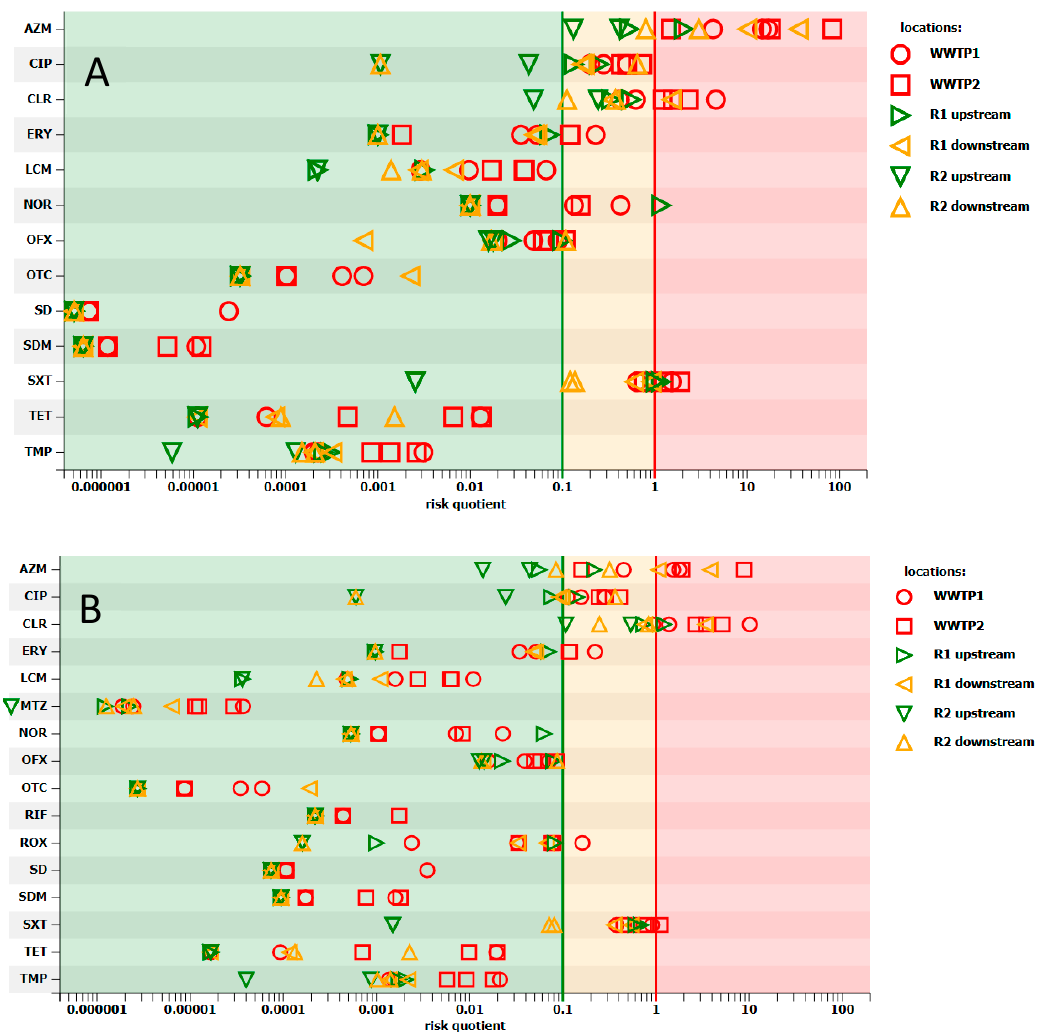
Figure 5. Estimation of risk quotients of chronic exposure of cyanobacteria ( A ) and eukaryotic organisms ( B ) to the antimicrobials occurring in effluents and receiving water. Calculations were based on the measured concentration of antimicrobials in wastewater and PNEC calculated based on [27]. Risk quotient below 0.1 indicates minimal risk (green area), between 0.1 and 1 is medium risk (orange area), and over 1 is high risk (red area).